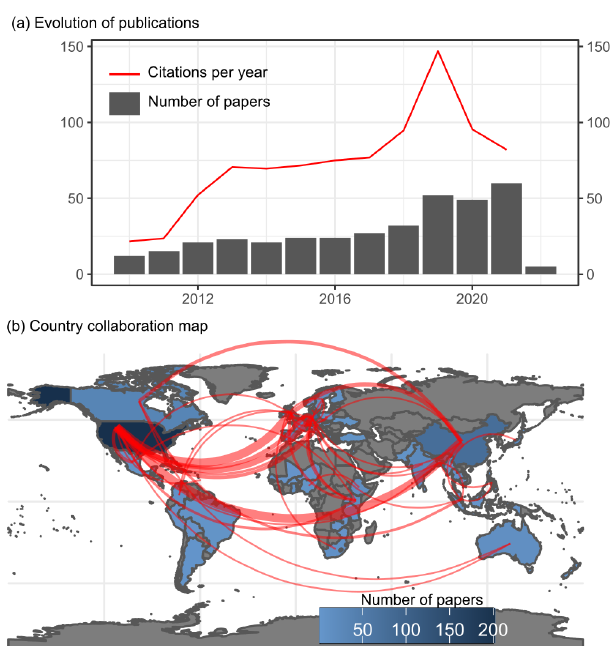
Figure 2. Weather index insurance studies. (a) Temporal distri- bution of papers collected from 1 January 2010 to 19 February 2022. (b) Thematic map representing the global collaboration net- work, where the countries in blue represent the number of stud- ies produced by scientists. The darker the color, the more affilia- tions the country has. The world vector map data were provided by https://www.naturalearthdata.com/ (last access: 8 March 2023) under public